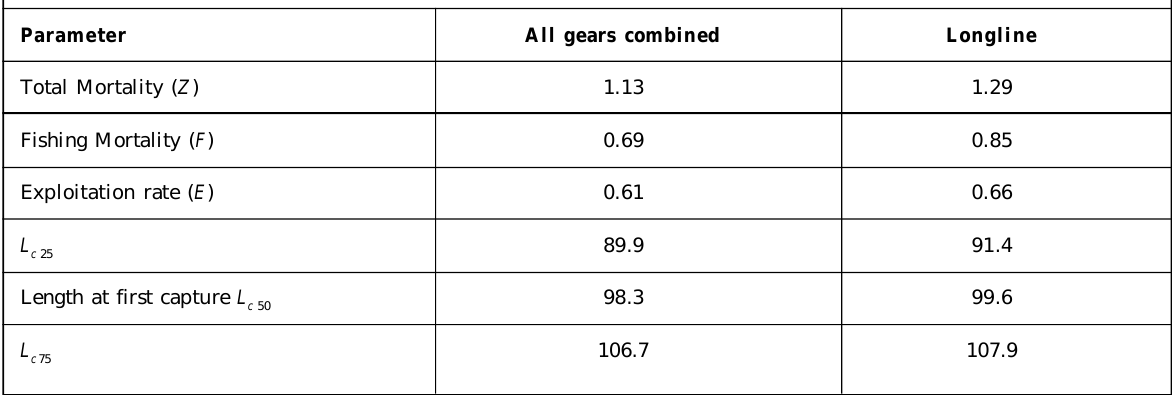
Table 1: Selectivity and mortality rates of Xiphias gladius from length converted catch curve and the probability of